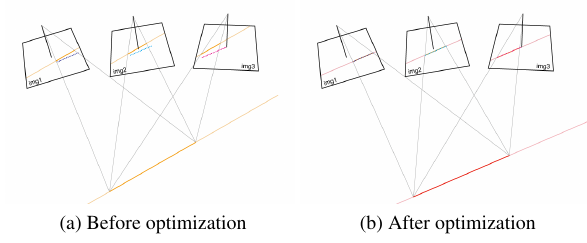
Figure 4. After optimization, the back-projection of the reconstructed line segment should best fit the extracted 2D lines in all the covering images.